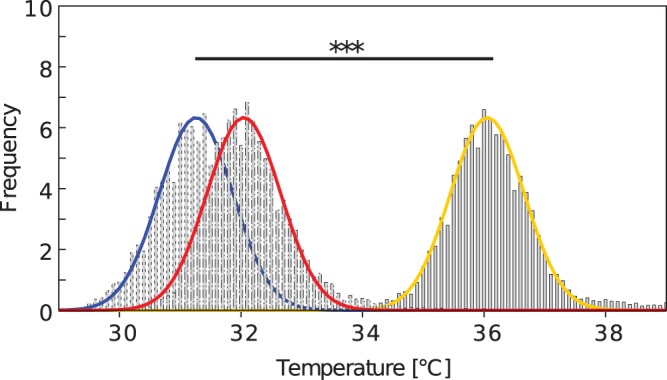
Temperature distribution of the different target temperatures in the arena in experiments with a complex gradient.Measurements of the central sensor of each zone are averaged over all experiments. The temperature distributions are significantly different between all three zones (p<0.05, T test). The targeted temperatures were as follows: outside the zones (blue): 31±1°C; right zone (red): 32±1°C; left zone (yellow): 36±1°C.